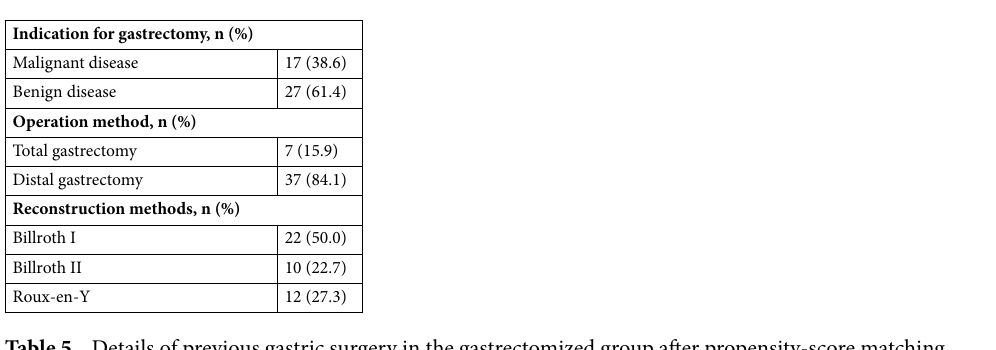
Table 5. Details of previous gastric surgery in the gastrectomized group after propensity-score matching (n = 44).